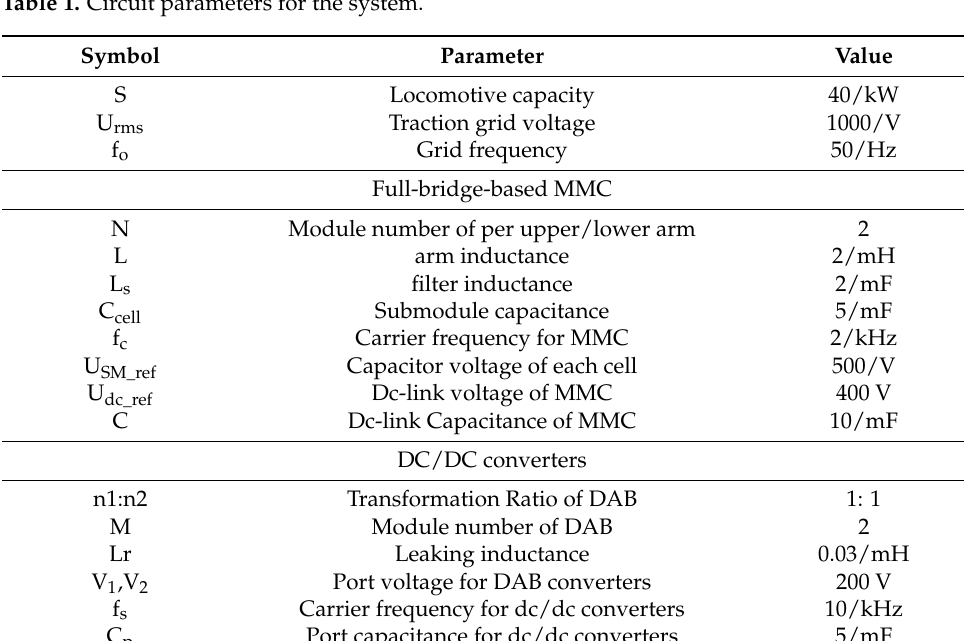
Figure 6. Physical implementation of the system. Table 1. Circuit parameters for the system.